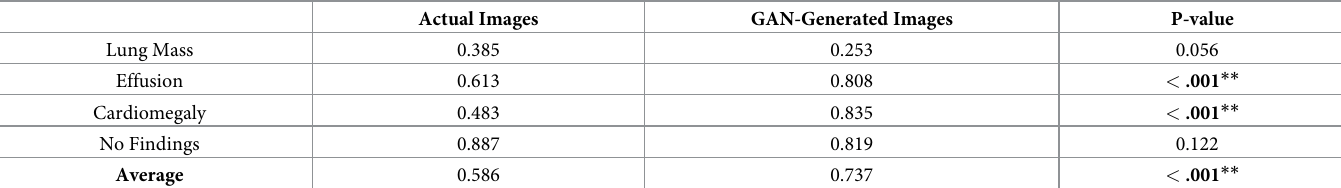
Table 5. Classification accuracy by lesion and image type.